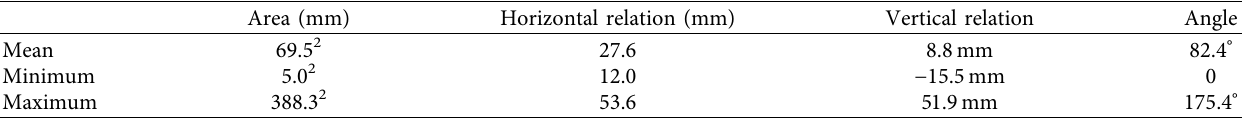
Table 1: Mean value of the surface area, horizontal relation, vertical relation, and angle.